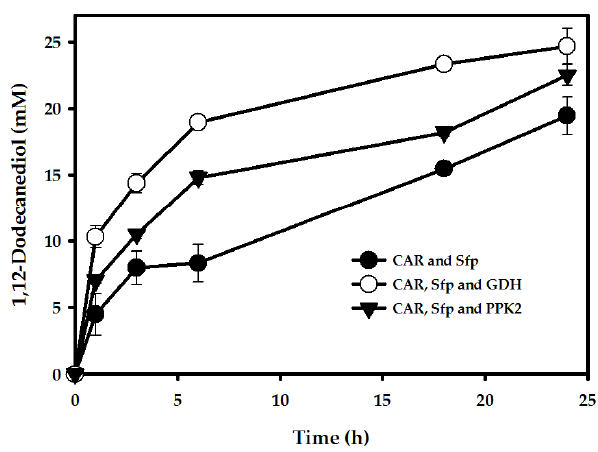
Figure 3. In vivo production of α , ω‐ diols using E. coli BW25113 ( ∆ fadD, DE3) cells expressing MmCAR and Sfp. Reaction conditions: Substrate, 30 mM ω‐ OHDDA; Volume, 10 mL in 100 mL flask; Temp, 30 °C; Buffer, 100 mM potassium phosphate buffer (pH: 7.5) with 1% glucose ( w / v ) and 10 mM MgCl 2 ; Cell OD 600 , 30.